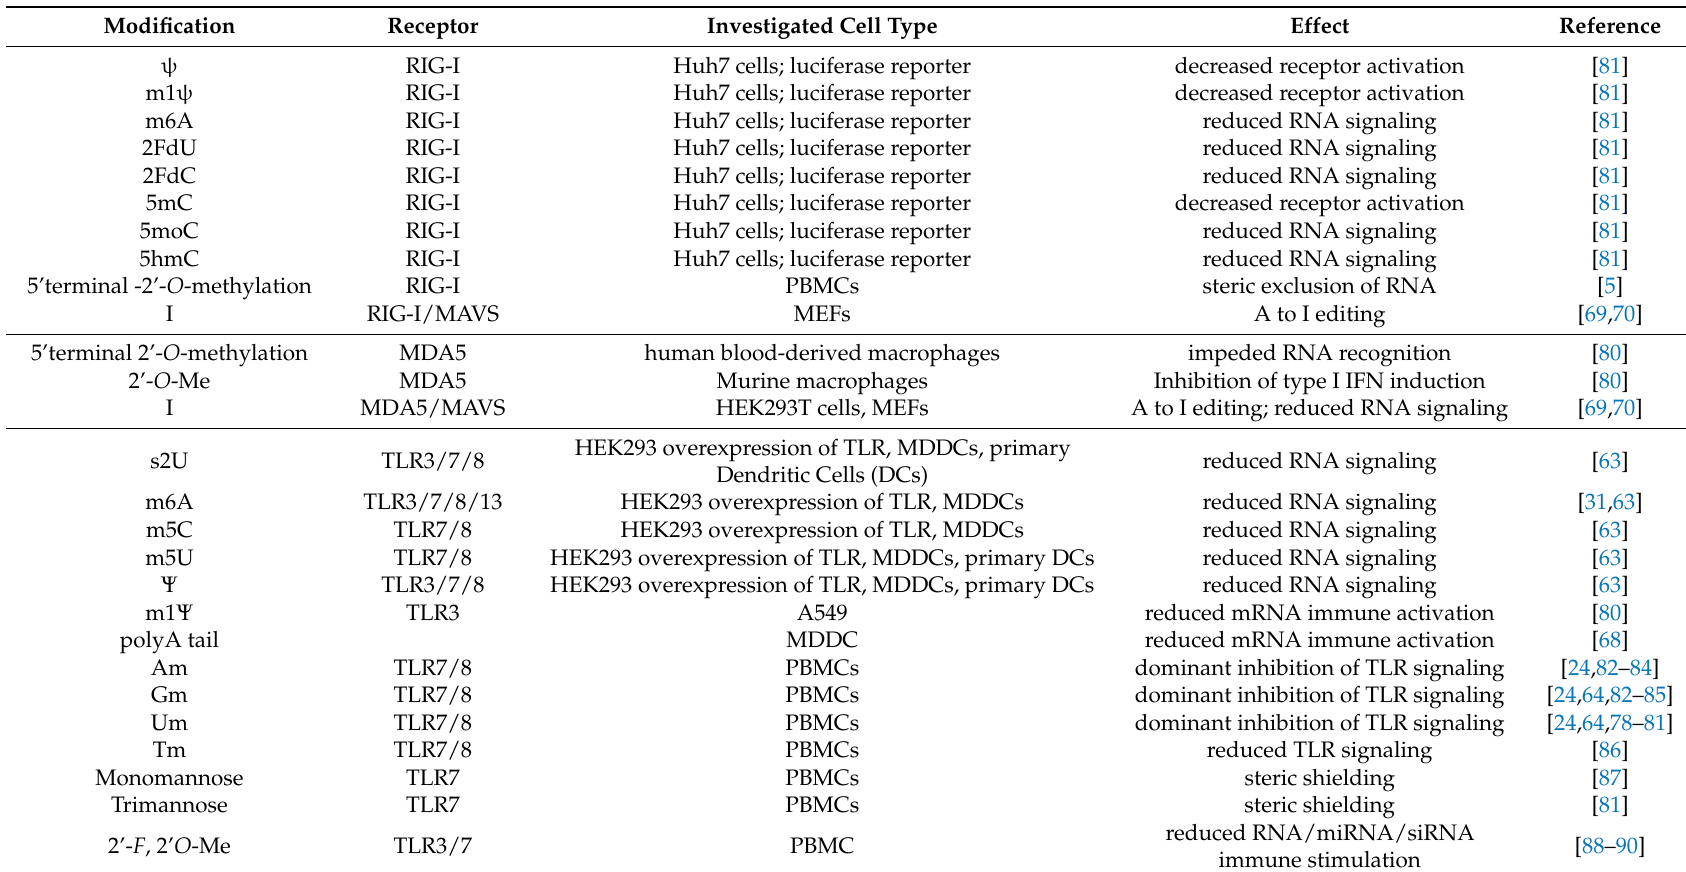
Table 1. Overview of selected immune modulatory RNA